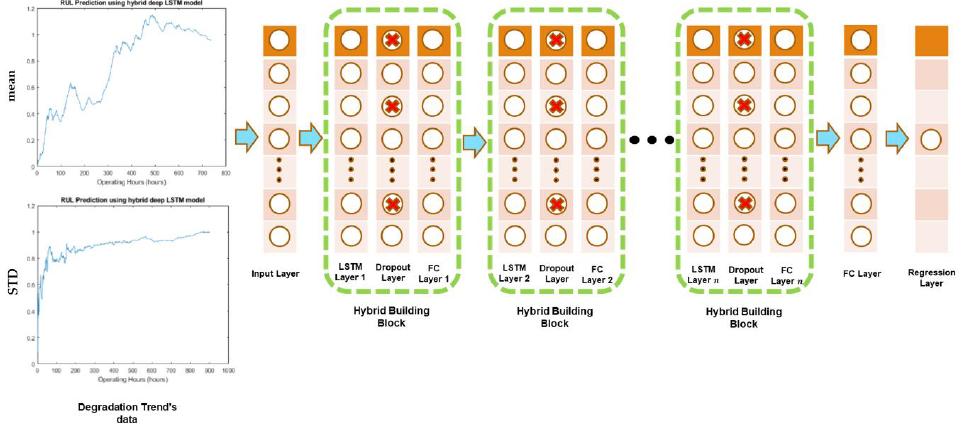
Figure 6. The architecture of the developed hybrid deep LSTM model.